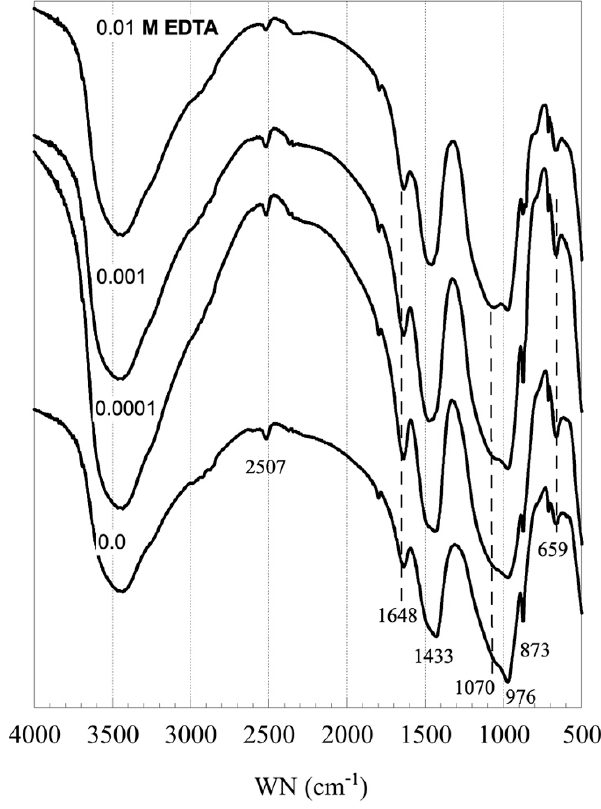
Figure 5. FTIR spectra of C-S-H solid phases, which were in contact with aqueous solution of varying EDTA concentration for 30 days.